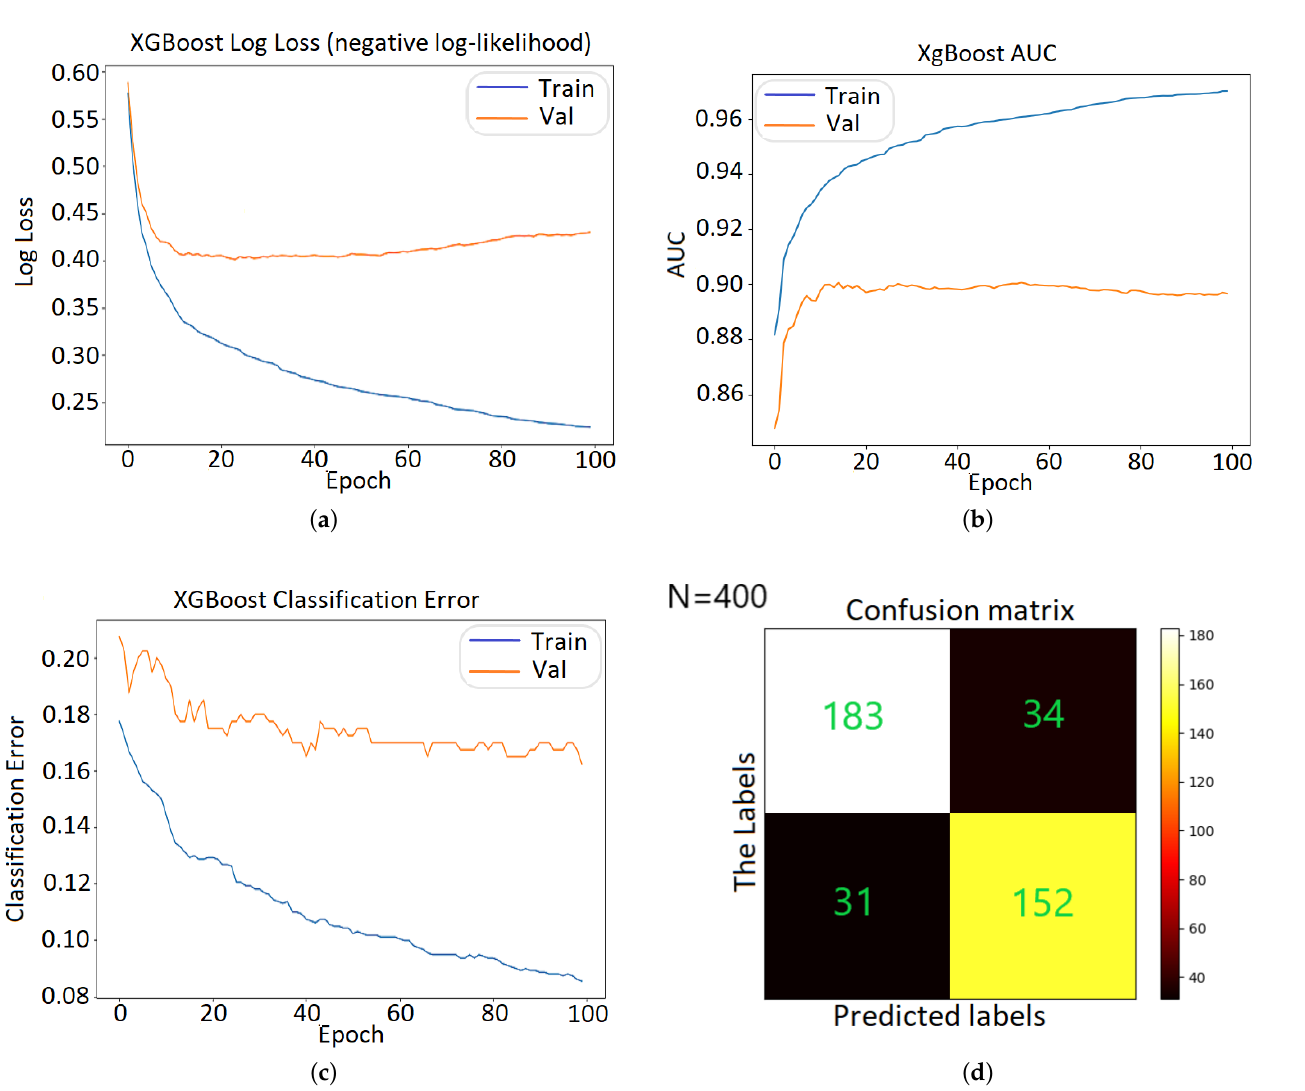
Figure 1. Performance curves of the XGBoost classifier: ( a ) log loss (negative log-likelihood); ( b ) AUC; ( c ) classification error; ( d ) confusion